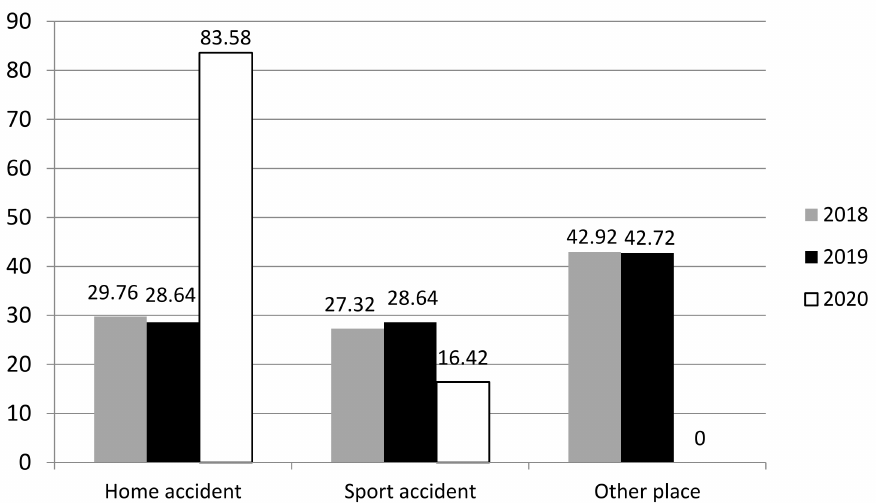
Figure 3. Comparison between 2018, 2019 and 2020 in terms of place in which trauma occurred (in